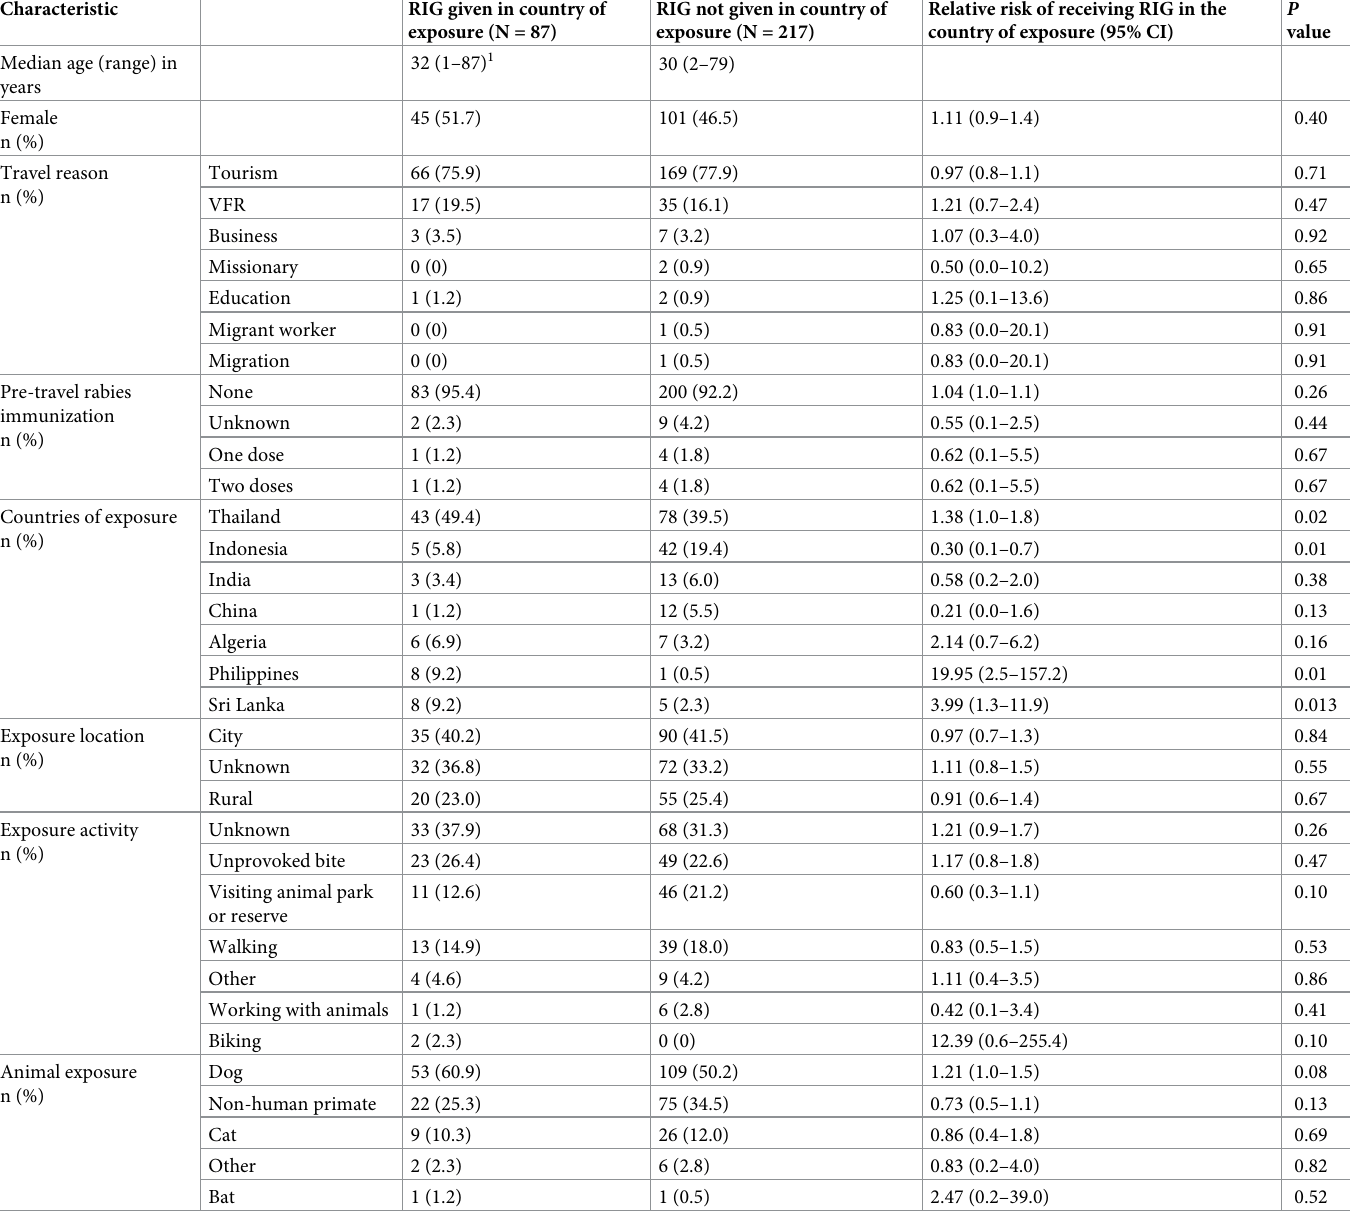
Table 3. Relative risk of receiving rabies immunoglobulin in the country of exposure when indicated, by traveler and exposure characteristics, September 2014–July 2017 (N = 304). Characteristic RIG given in country of